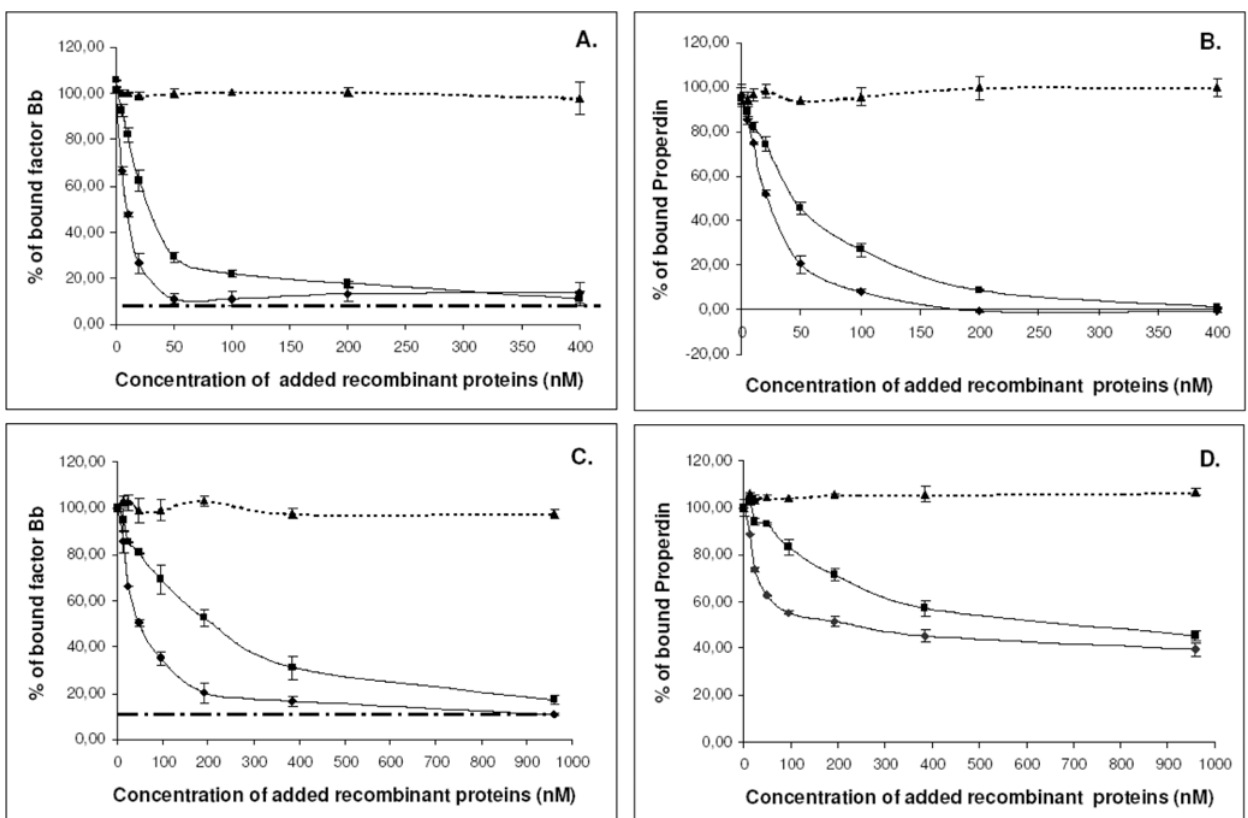
Figure 8. Effect of IxAC proteins on the formation and stability of C3 convertase. Panel A and B: The effect of IxAC proteins on the formation of C3 convertase was evaluated by incubating simultaneously purified factors B, D and properdin with increasing amounts of IRAC II or IxAC-B1 on C3b- coated wells. Panel C and D: The effect of IxAC proteins on the stability of C3 convertase was assessed by incubating preformed C3 convertase (fB, fD and properdin pre-incubated for 1 hour) on C3b-coated plates with increasing amounts of recombinant IxACs. Bound factor B or properdin was detected with an anti-factor B antibody (A–C) or anti-properdin antibody (B–D), respectively. Recombinant IRIS was used as negative control. Black diamond: IRAC II; black square: IxAC-B1; black triangle: IRIS.